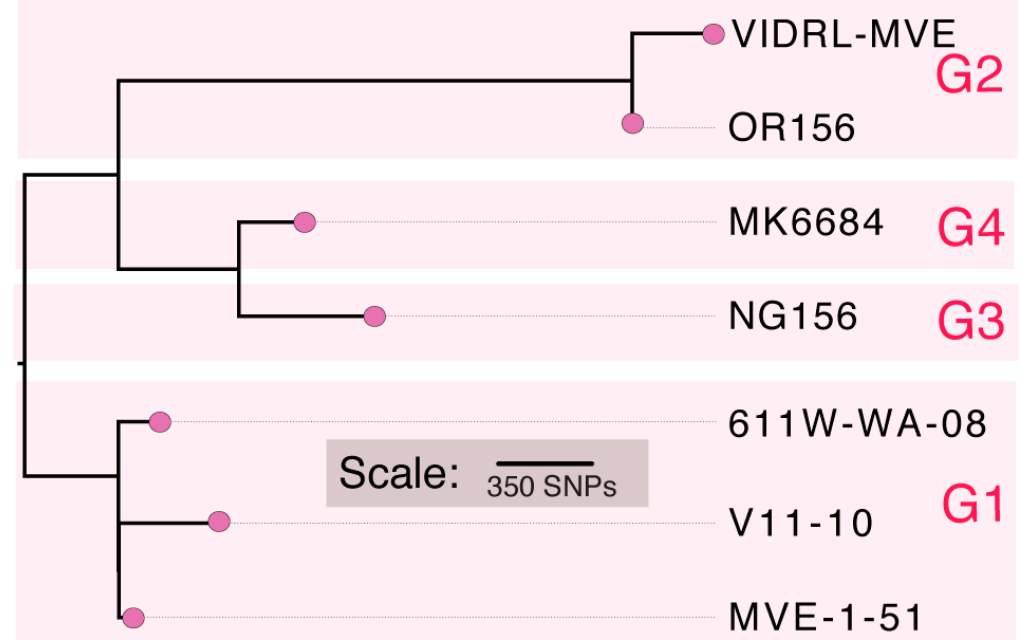
Figure 1. Maximum Likelihood tree (mid-point rooted) showing the phylogenetic relatedness of publicly available Murray Valley Encephalitis virus (MVEV) full genome sequences in comparison to VIDRL-MVEV. Isolate 611-WA-08 was used as the reference strain. Viral genotype (G1–G4) is also shown next to each taxon. OR156 is the G2 ancestral reference strain. All nodes had FastTree support values >0.95.